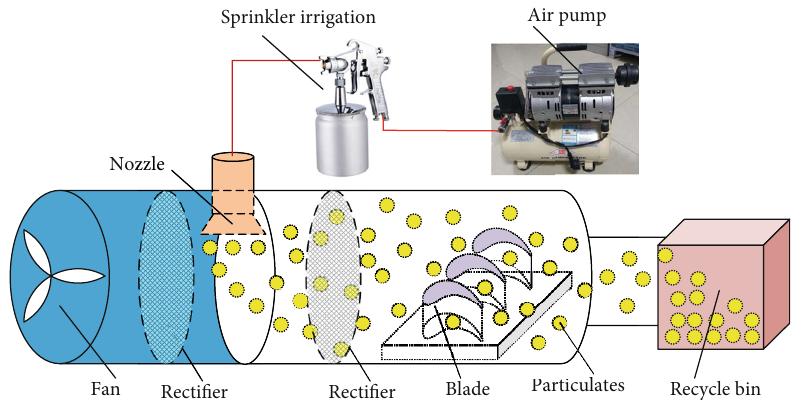
Figure 3: Schematic diagram of the experimental system.